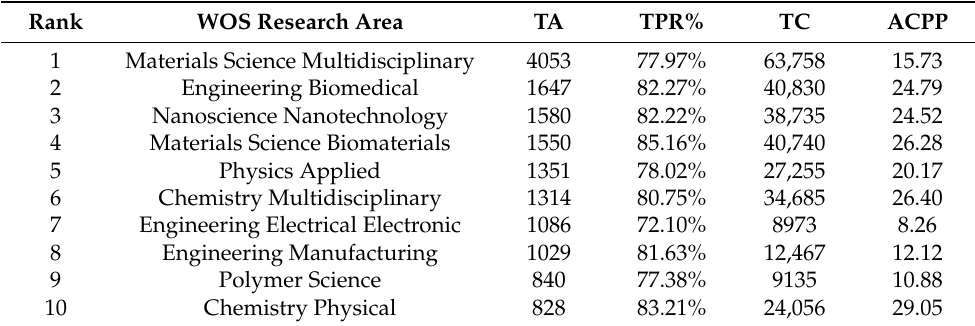
Table 3. Contribution of leading research